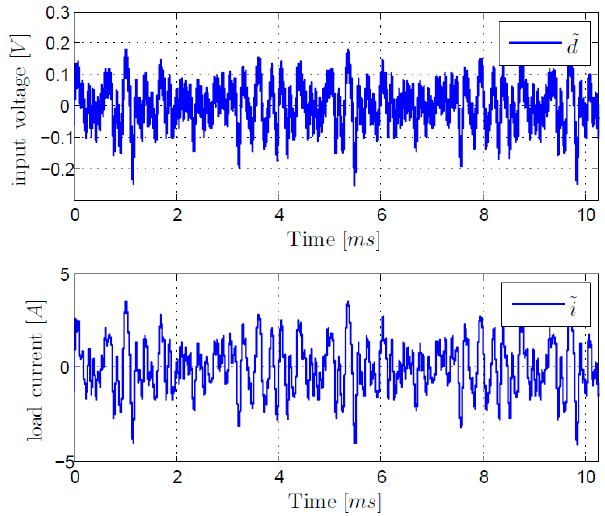
Figure 11. Plant input and output signals for identification (AC coupled).